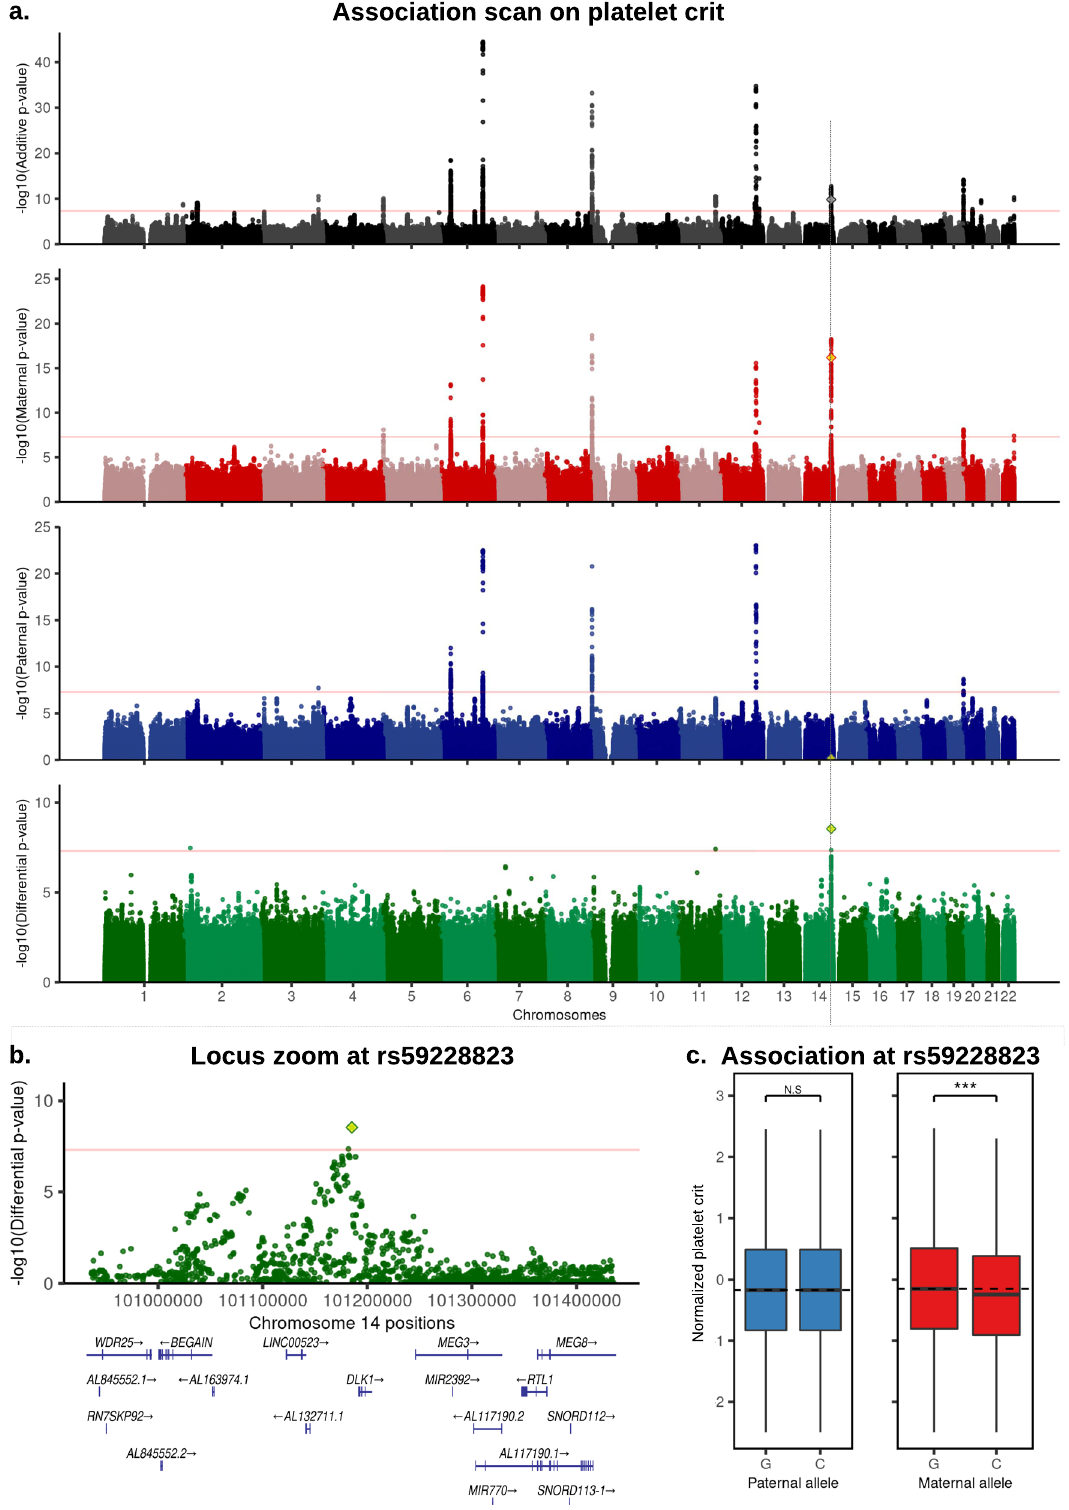
Fig. 3 | Association scans for PofO effects on platelet crit. a Manhattan plots of fourassociationscanswithplateletcrit.Fromtoptobottomplotsareshownresults for additive (black), maternal (red), paternal (blue) and differential (green) scans. Theleadvariantmentionedinthisstudy(rs59228823)isshownwithadiamond.Red horizontal lines indicate genome-wide signi fi cance threshold at − log10(5×10 − 08 ). b Locus zoom at rs59228823 on the differential scan. c Box plot of the normalized plateletcrit( y -axis)strati fi edbyriskallelesandoriginatSNPrs59228823;paternalin